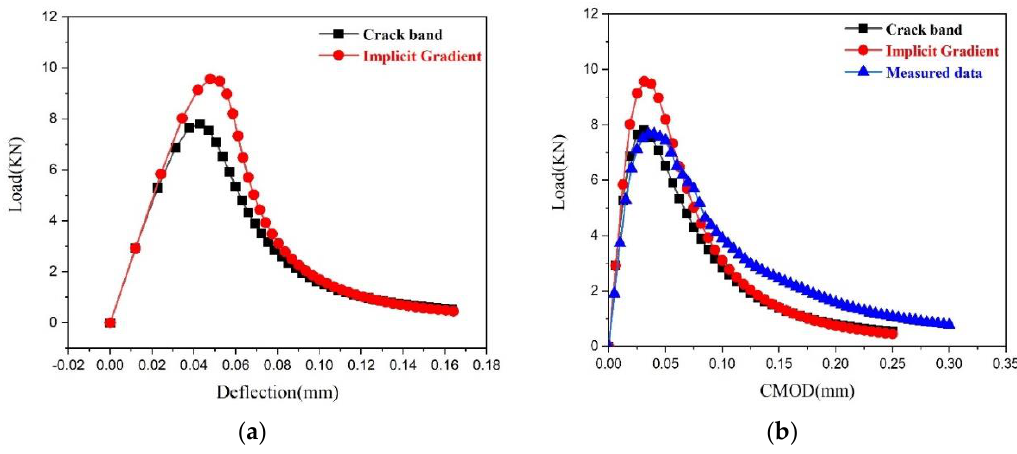
Figure 11. Curves of ( a ) load-displacement and ( b ) load and CMOD.